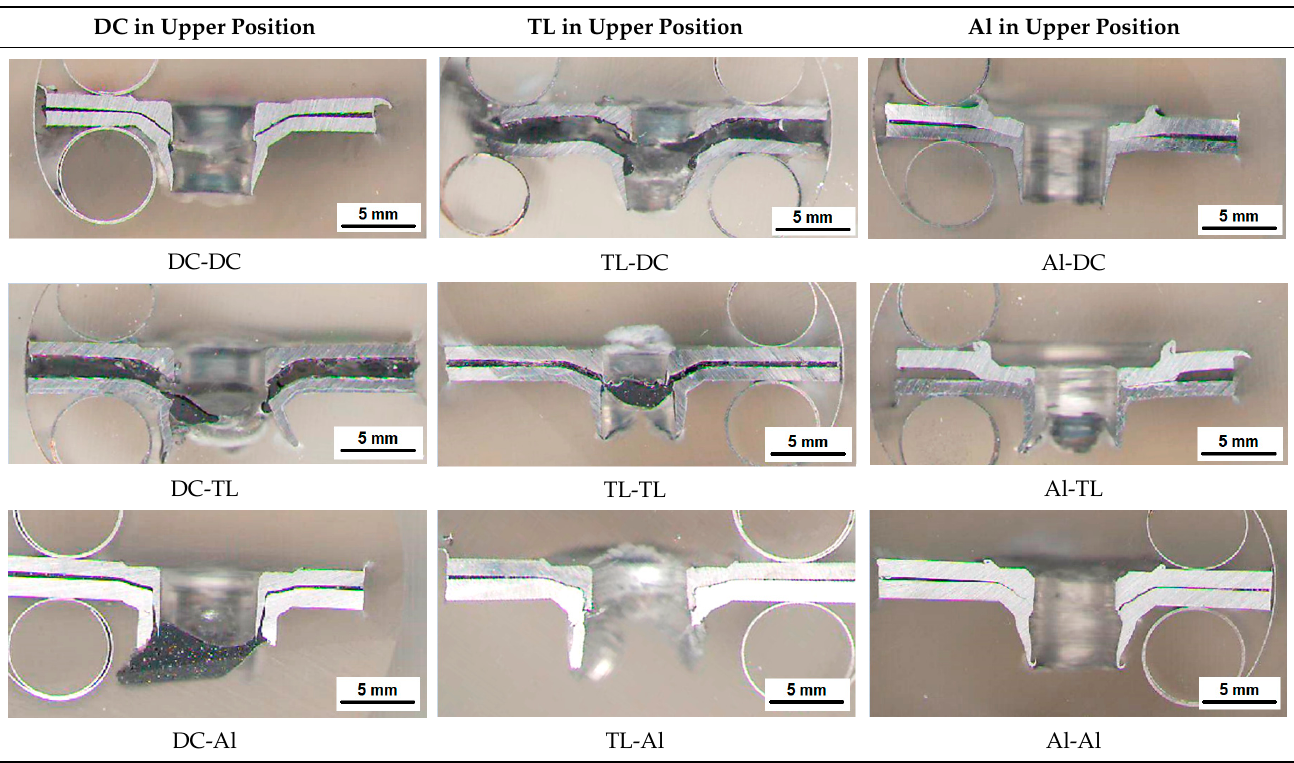
Table 7. Macroscopic sections of individual flowdrill joints.